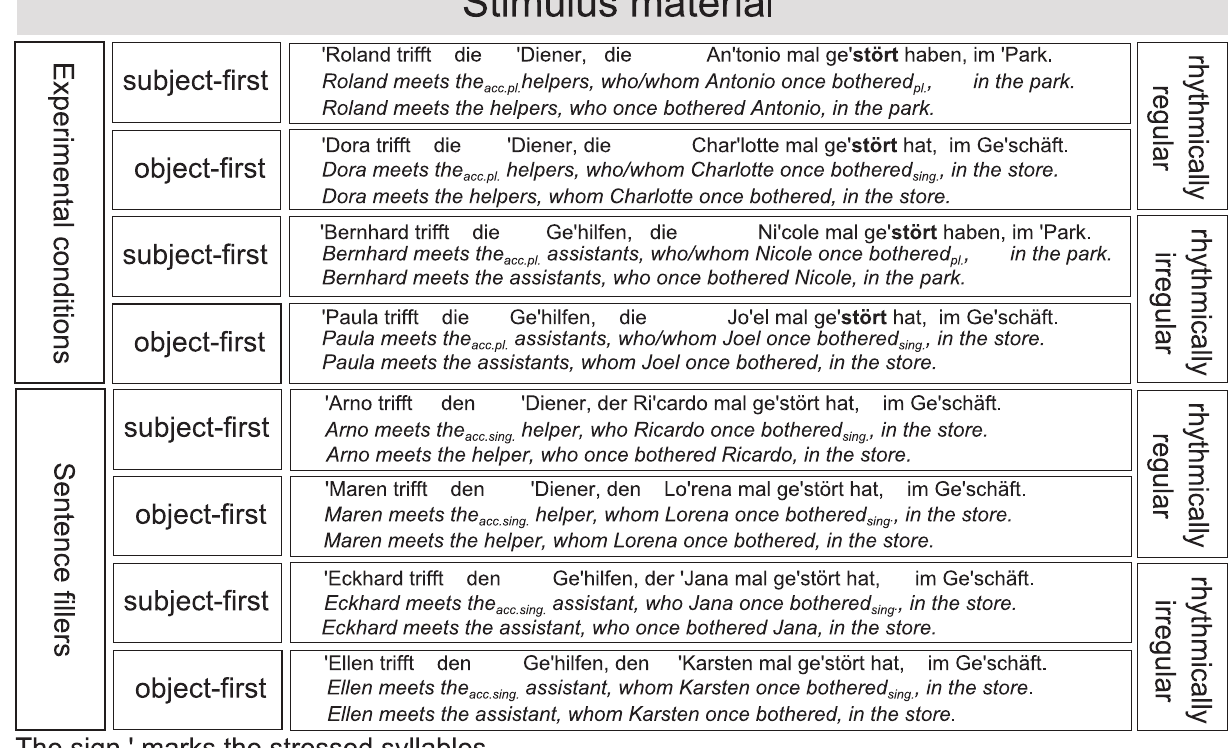
Figure 2. Exemplary sentence for each experimental condition and filler sentences.